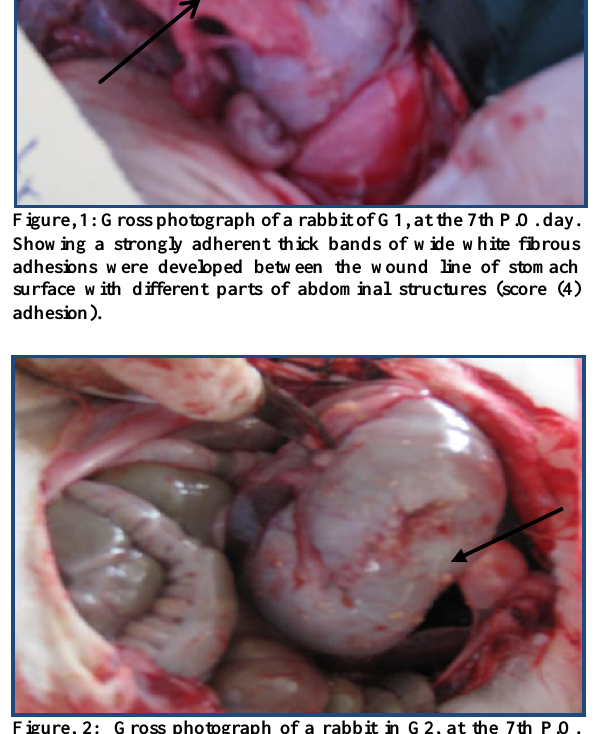
Figure, 4: Gross photograph of a rabbit of G2, at the 21st P.O. day. Showing no any indictable adhesion, the incision line healed without attachments, no signs of adhesion at entire organs of the abdomen cavity.